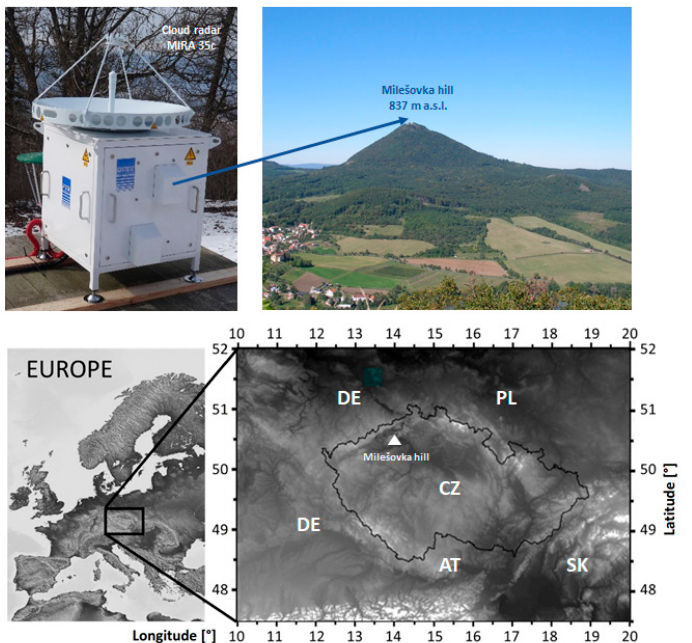
Figure 1. Placement of the cloud radar MIRA35c at the Milešovka observatory situated at the top of Milešovka hill (837 m a.s.l.) and its geographical location in Czechia in Central